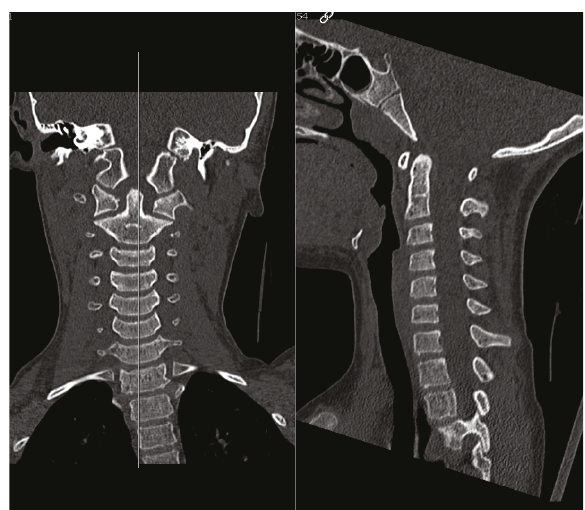
Figure 2: CT scan of C-spine.